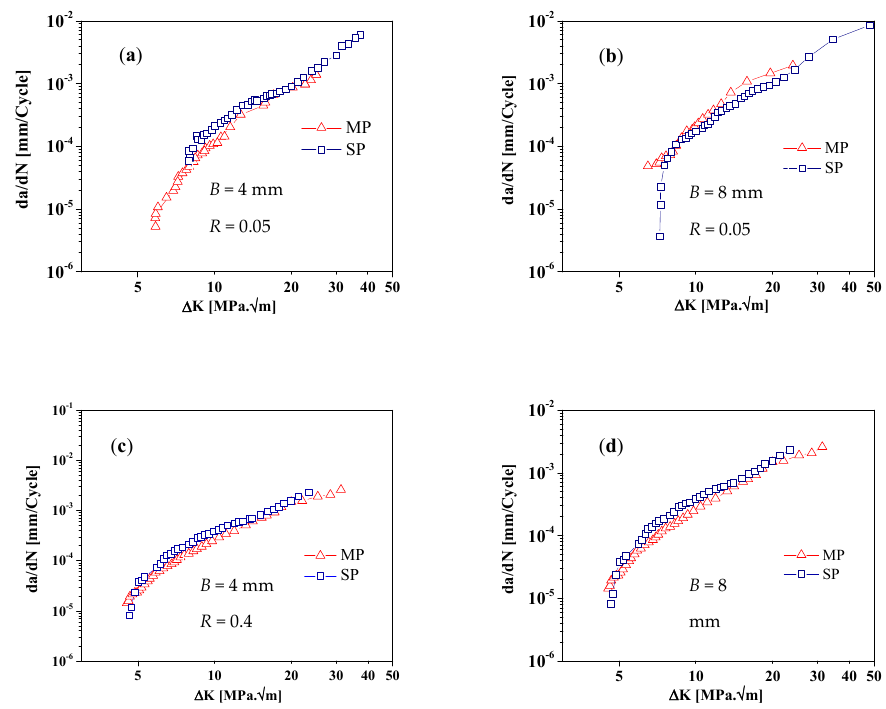
Figure 6. Shot peening effect on da/dN- ∆ K curves for specimens: ( a ) B = 4 mm, R = 0.05; ( b ) B = 8 mm, R = 0.05; ( c ) B = 4 mm, R = 0.4; and ( d ) B = 8 mm, R = 0.4.